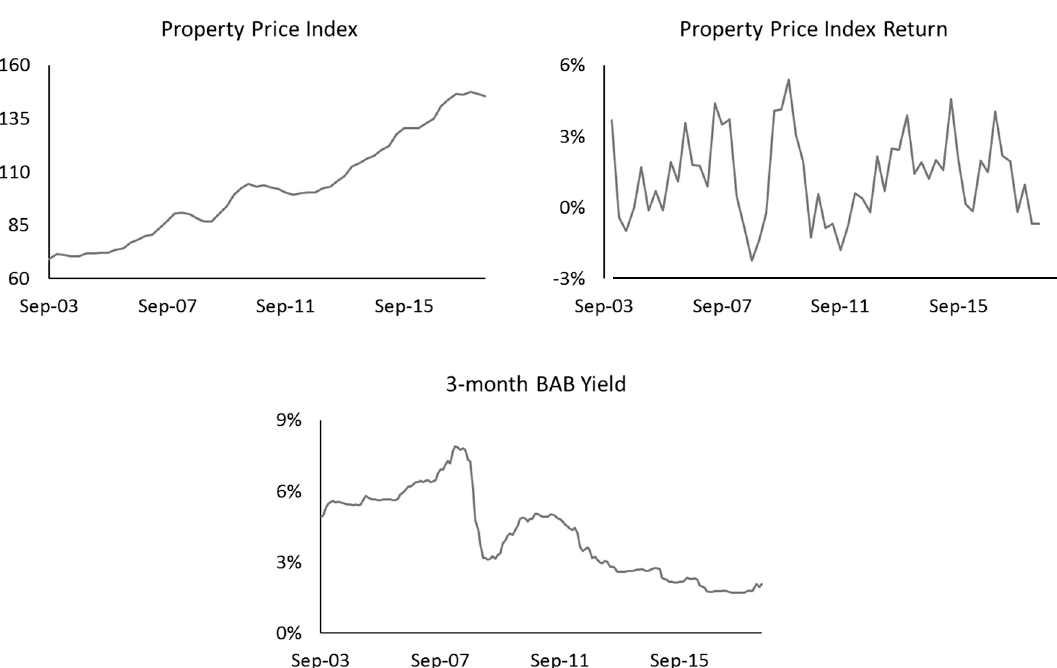
Figure 3. Simulated density functions of future survival probabilities of the cohort aged 65 (at the start of 2019) for 10, 20 and 30 years.